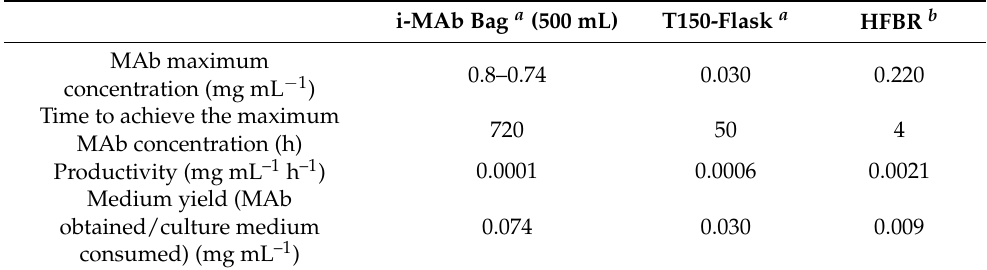
Table 3. MAb production data employing different culture techniques